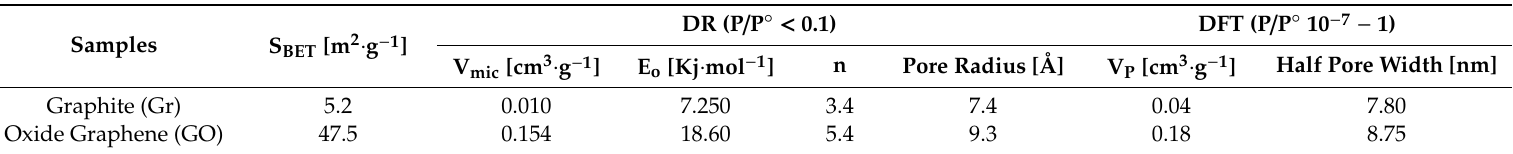
Table 1. Dubinin–Radushkevich (DR) and functional theory of density (DFT) parameters obtained from the adsorption-desorption isotherms of N 2 at 77.4 K.